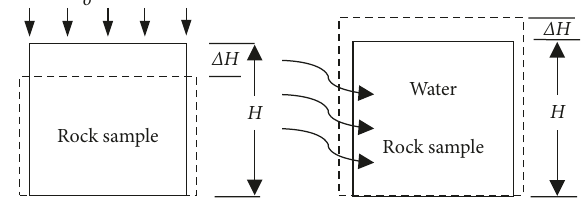
Figure 5: Sign convention of deformation.